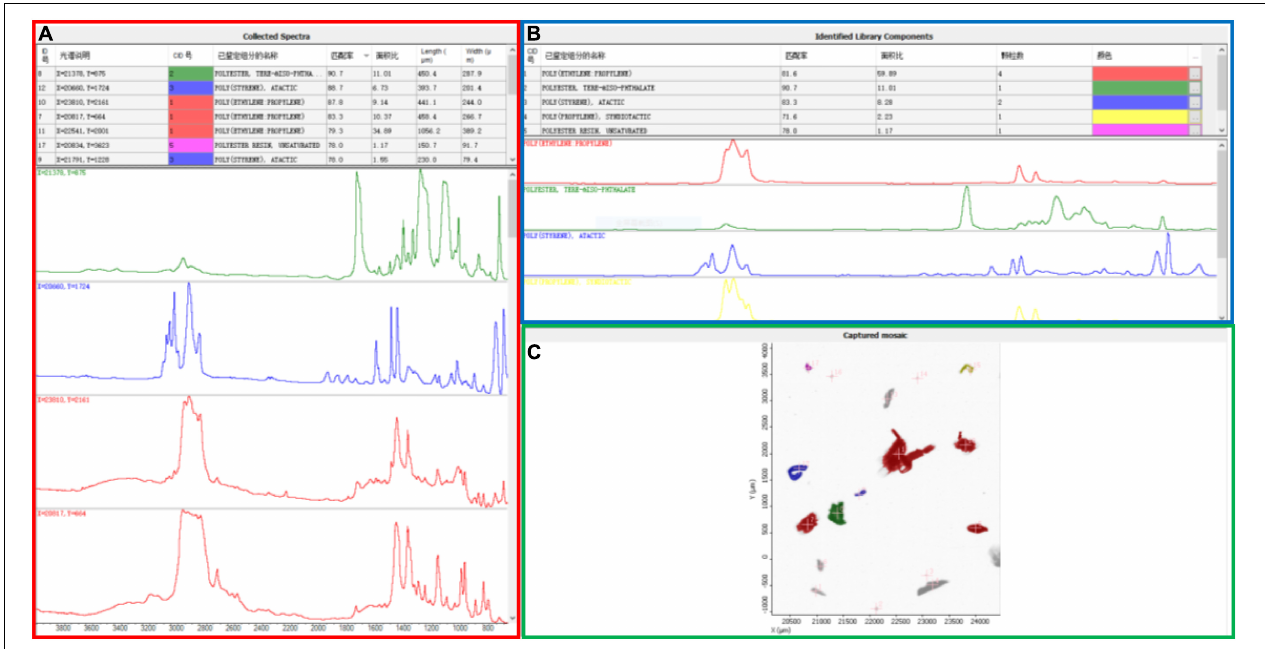
FIGURE 2 | Representative analysis results for MPs collected from beach. The same color indicates the information from the same particle. (A) Collected spectra and information of each particle under the µ -Fourier transform infrared ( µ -FTIR) spectroscopy, including particle position, identified component name, matching degree, and the length and width of the particle; (B) identified library components of these particles, reporting the number of particles; (C) scan results for gold-coated microslide with micron-size